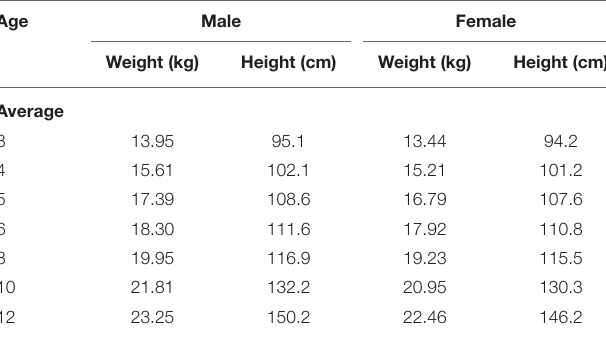
TABLE 1 | Height and size table of difficult children of different ages in the “SOS children’s